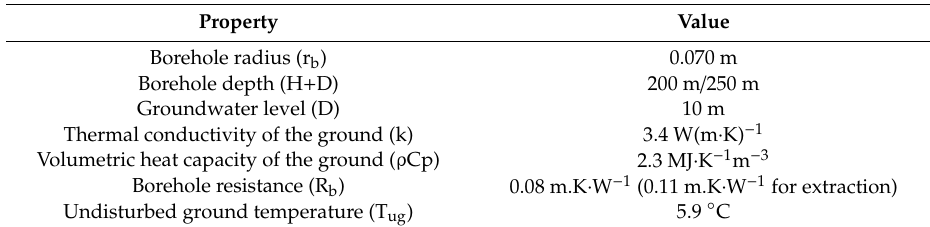
Table 1. Properties of the BHE.